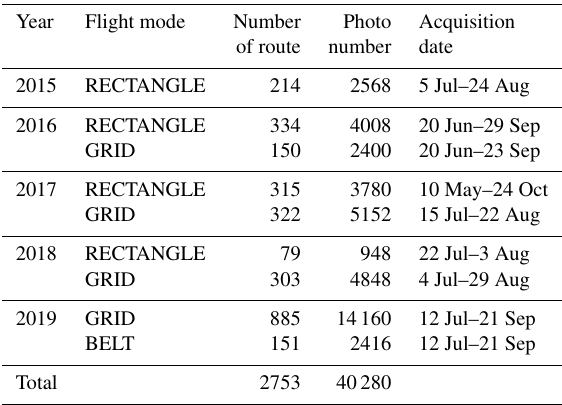
Table 1. UAV sampling information from 2015 to